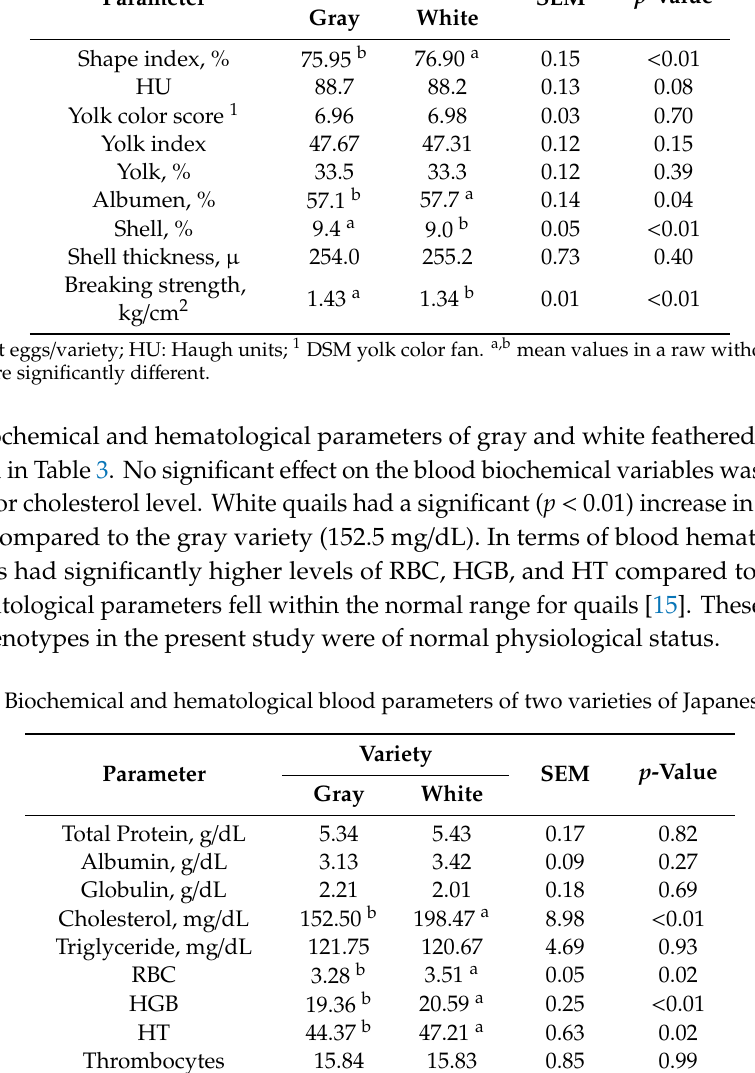
Table 2. Internal and external egg quality of two varieties of Japanese quails. Variety Parameter SEM p -Value Gray